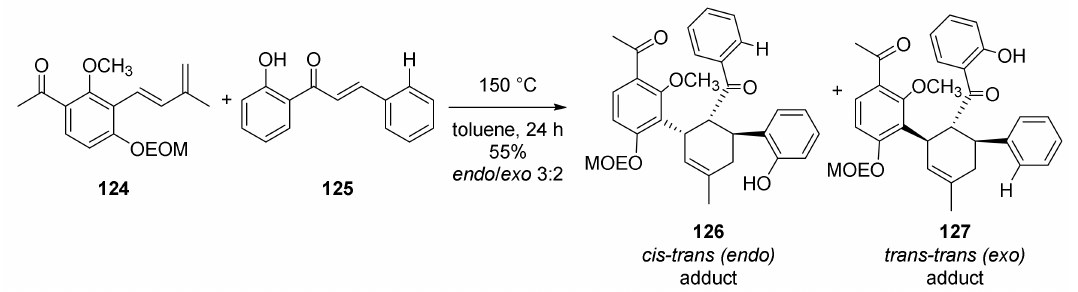
Figure 40. Biogenesis of morusalbanol A ( 18 ) and related natural products.